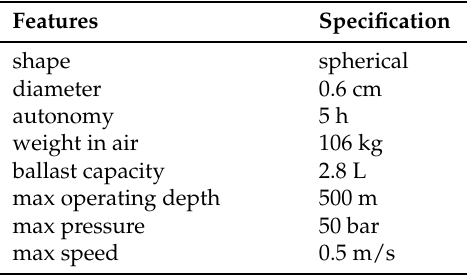
Table 1. Characteristics of the UX-1 robot.